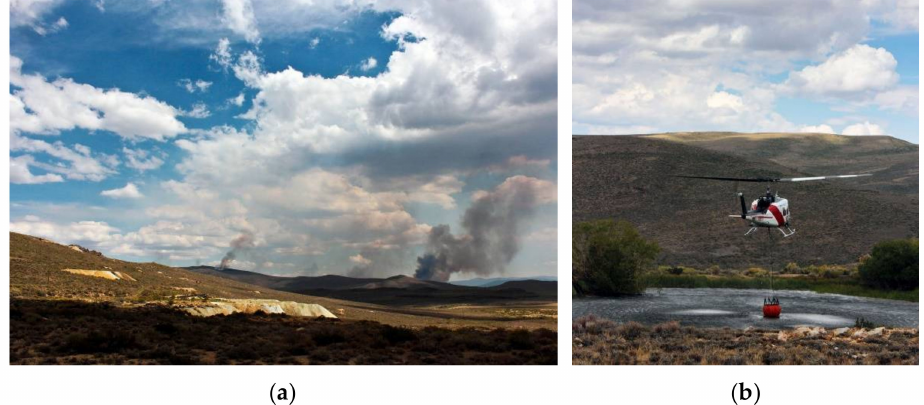
Figure 5. ( a ) Plumes of smoke from the Spring Peak fire are seen in the landscape near Bodie; ( b ) a fire crew’s helicopter is seen filling up a bucket at a pond at Bodie. Photographs courtesy of California State Parks and U.S. Forest Service.